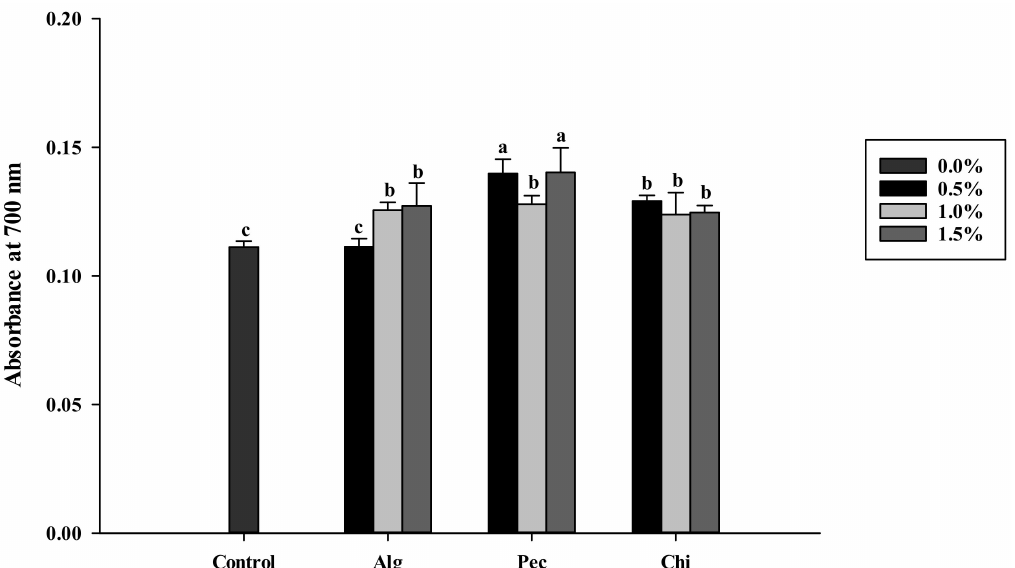
Figure 3. Reducing power of biscuits added of different concentrations of sodium alginate, pectin and chitosan. a, b, c: indicate statistically significant difference ( p < 0.05) among treatments ( n = 3). Alg: Sodium alginate; Pec: Pectin; Chi: Chitosan.